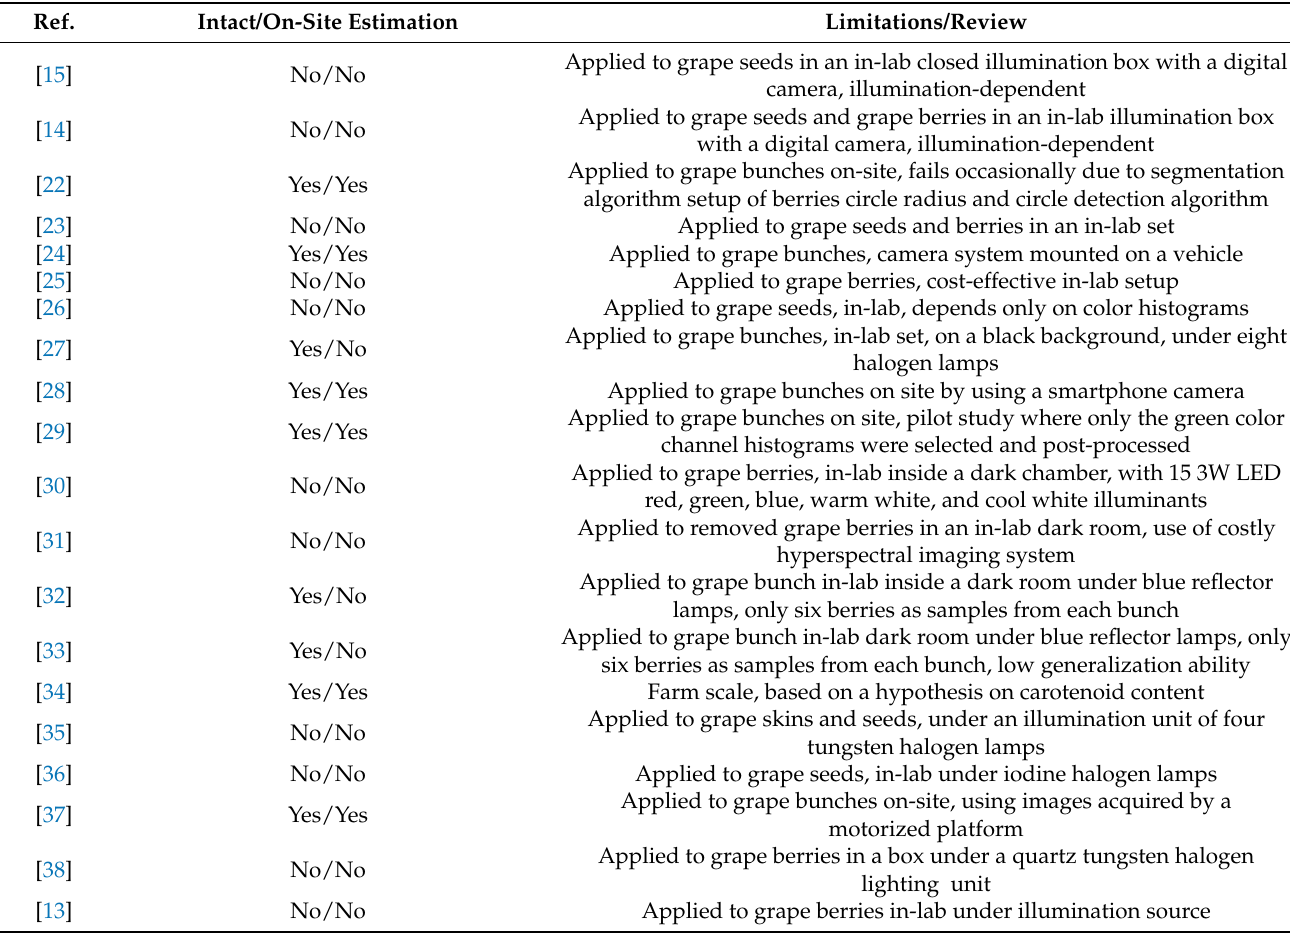
Table 7. Peculiarities and characteristics of the referenced methodologies.